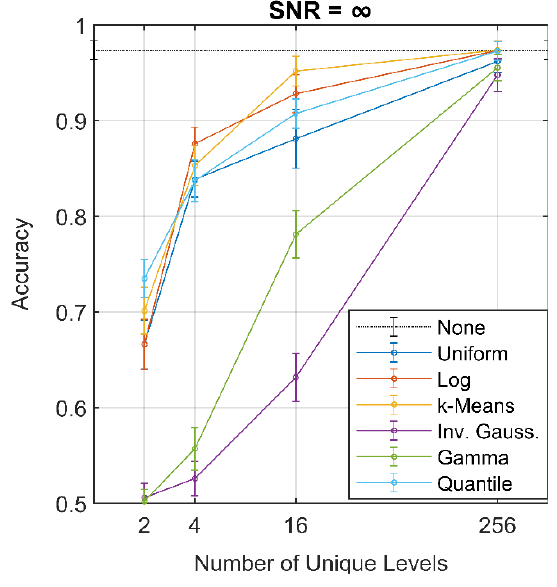
Figure 8. Accuracy of the quantizer scales for SNR = ∞. The steepest decrease in accuracy occurred in the gamma and inverse Gaussian scale between K = 256 and K = 16. This was likely caused by poor choice of the quantization values at the input and the first s-layer. The input to the network contained 64 2 = 4096 values, which were quantized to K unique values. For K = 256, the maximum number of unique quantization levels is 256; if all 4096 values of the input are unique and all 256 levels exist in the input, then only 256/4096 = 0.0625 of the input is accurately represented, with the remaining 0.9375 of the input quantized. For K = 16, the fraction of unique quantization levels to unique values in the input reduces to 0.0039. Poor selection of initial quantization levels would, therefore, have a significant impact throughout the network. In addition, by quantizing to fewer levels, the output from the following layer likely loses the distribution shape found in the non-quantized data, such that the pre-selected PDF is no longer the best-fit within the